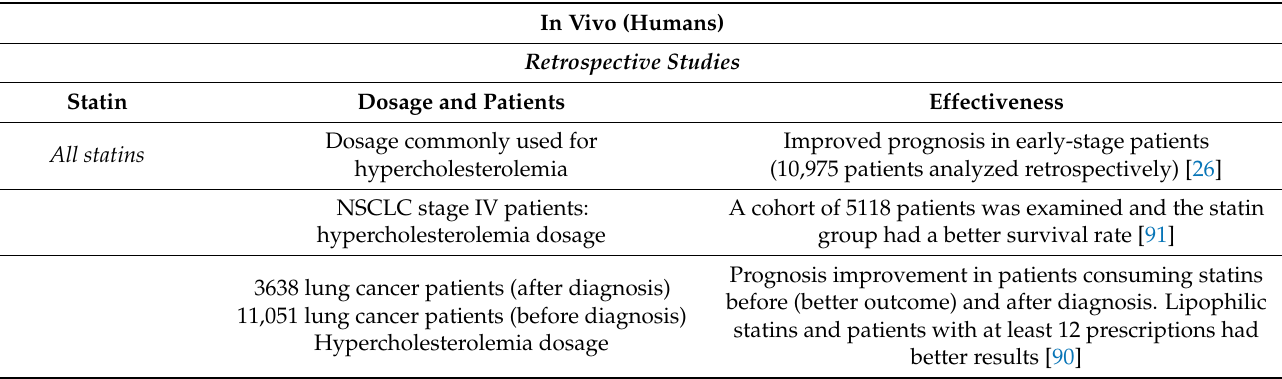
Table 9. Human studies of statins in lung